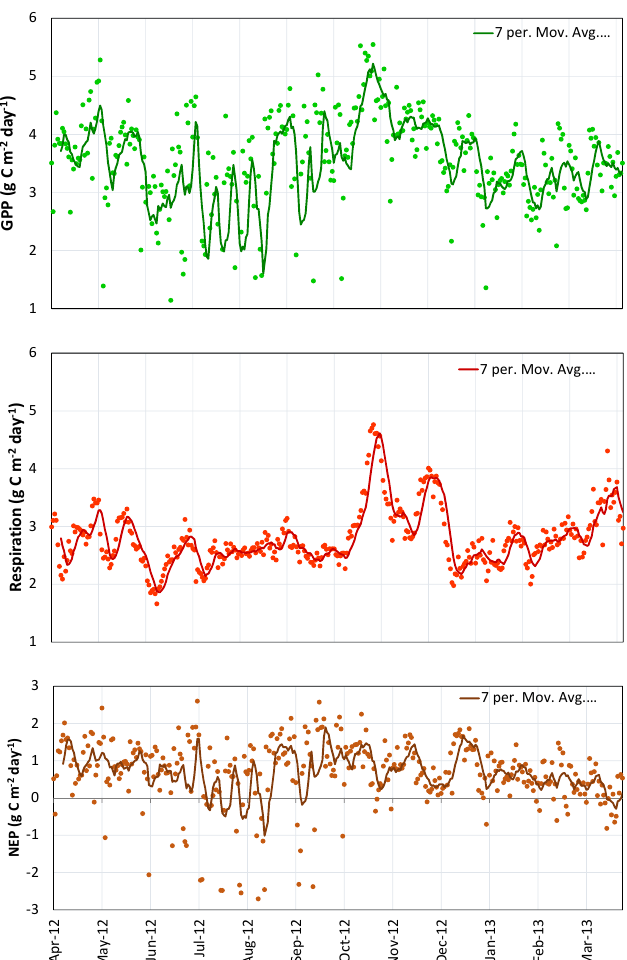
Figure 11. Daily average of partitioned flux into gross primary productivity (GPP), respiration (Re) and net ecosystem productivity (NEP) over the study period. Bold lines represent seven-day running mean.